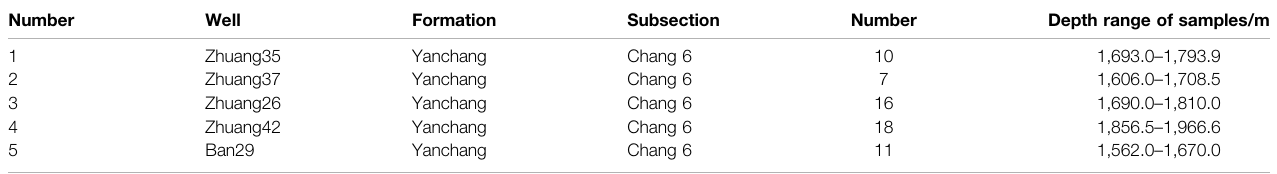
TABLE 3 | The number, well name, formation, subsection, and depth range of samples used in the sandstone grain size analysis. See Figure 2 for the location of wells. See Figure 1 for the location of wells. Number